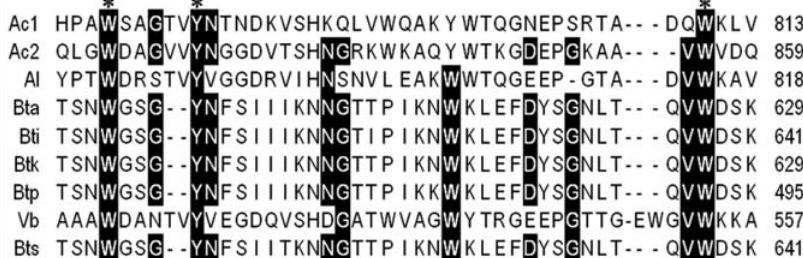
Figure 3 - Composition of the C-terminal domain of Bacillus thuringiensis ( Bt ) serovar sotto ( Bt sotto ) chitinase (Chi) Schi with chitin-binding domain (ChBD) of other chitinase. Sequences are from Aeromonas caviae ChiA ( Ac1 and Ac2 ), Alteromonas sp. strain O-7 Chi85( Al ), Bt alesti ChiA74-HD16 ( Bta ), Btisraelensis Ichi( Bti ), Btkenyae ChiA74( Btk ), Btpakistani ChiA71( Btp )and Vibrioharveyi ChiA( Vb ).Highlyconservedaromaticaminoacids are marked with an